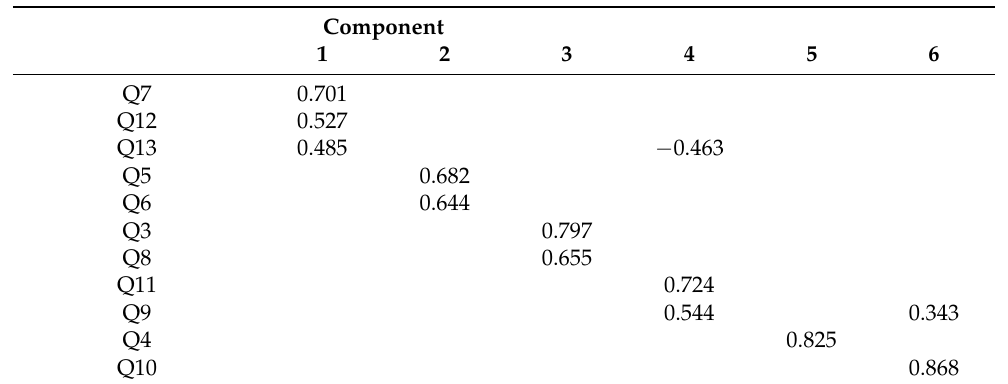
Table 10. Matrix of rotated components to obtain values for each question and their incidence in 6 components.